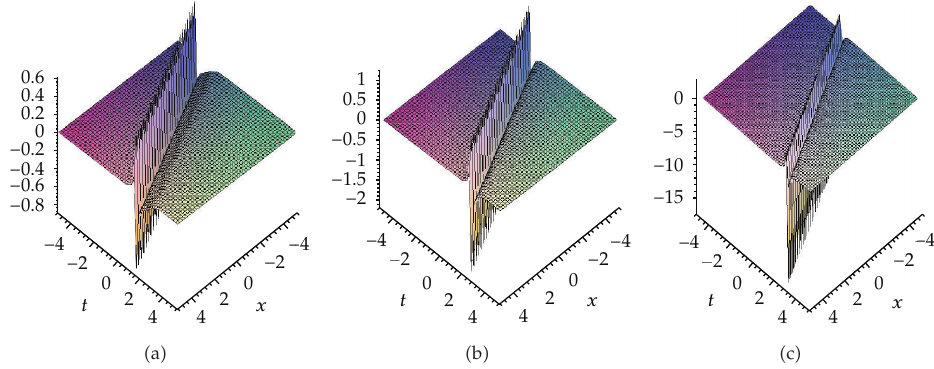
Figure 5: Evolutional behaviour of u 2 describes singular wave solution: (cid:3) a (cid:4) p (cid:7) 1 , q (cid:7) 1 / 32; (cid:3) b (cid:4) p (cid:7) 1 , q (cid:7) 3; (cid:3) c (cid:4) p (cid:7) 1 , q (cid:7) 27.